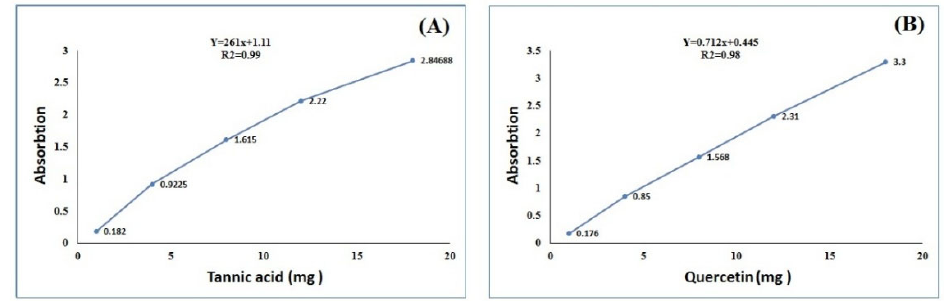
Figure 5. Quantitative analysis of total phenolic ( A ) and flavonoid content using a standard curve ( B ).